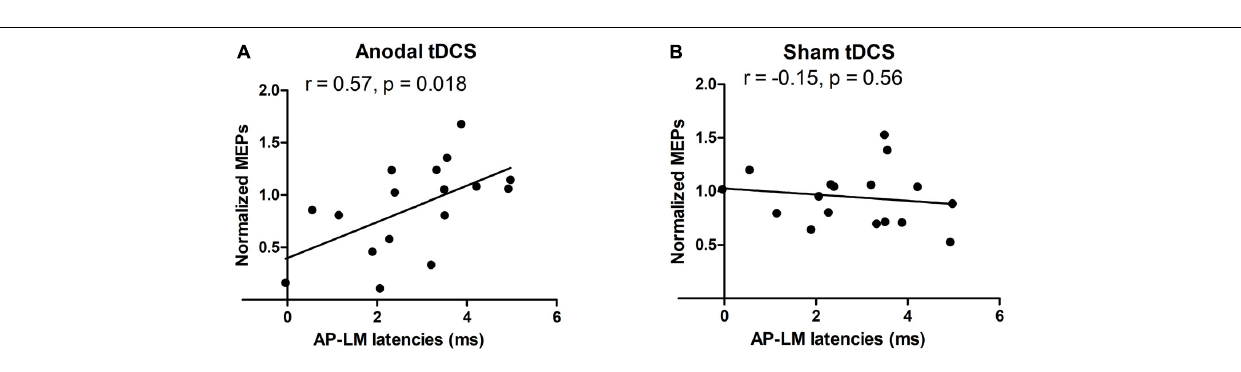
FIGURE 4 | Relationships between the normalized TMS amplitudes and AP-LM latency. A positive correlation was found just after the anodal session (A) , but neither just after the sham session (B), nor 1 h after each stimulation. For the y -axis a value of 1 is equivalent to no change from